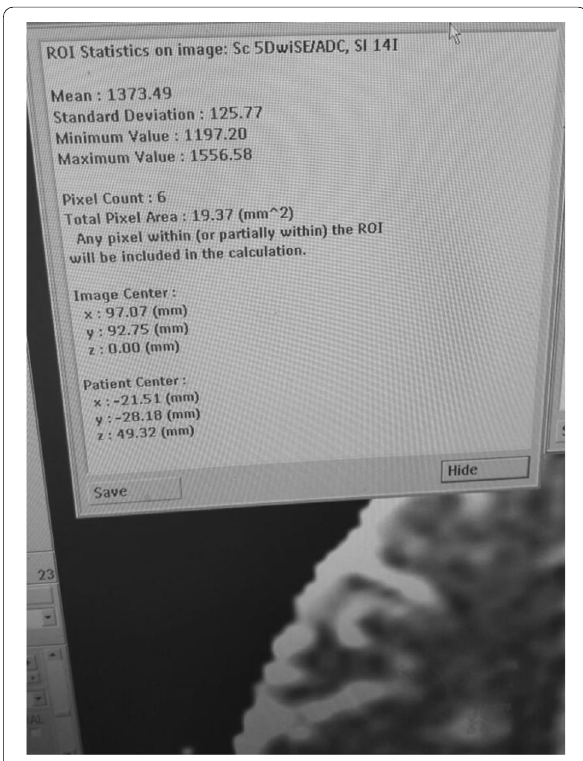
Fig. 4 A 24 year patient diagnosed as RRMS; ROI was placed on an MS plaque at an ADC map for recording the ADC value of 1.373 10 − 3 mm 2 /s ×